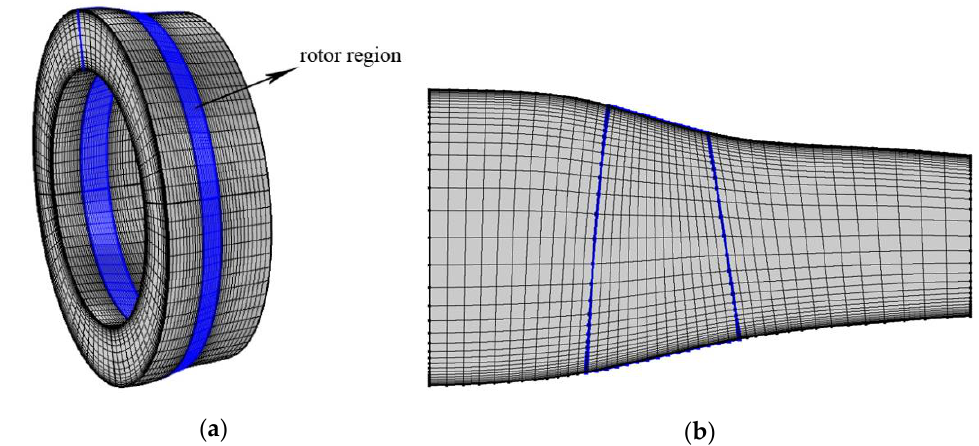
Figure 8. HMNF module computational mesh. ( a ) 3D view and ( b ) Meridional plane view.